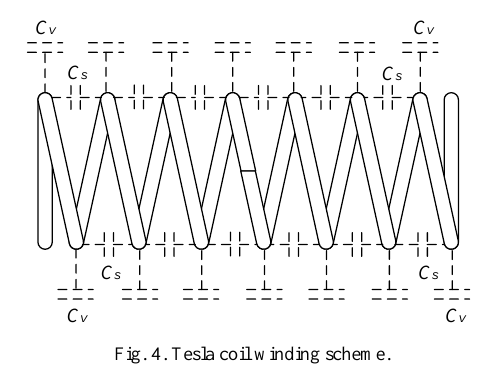
Fig. 4. Tesla coil winding scheme.